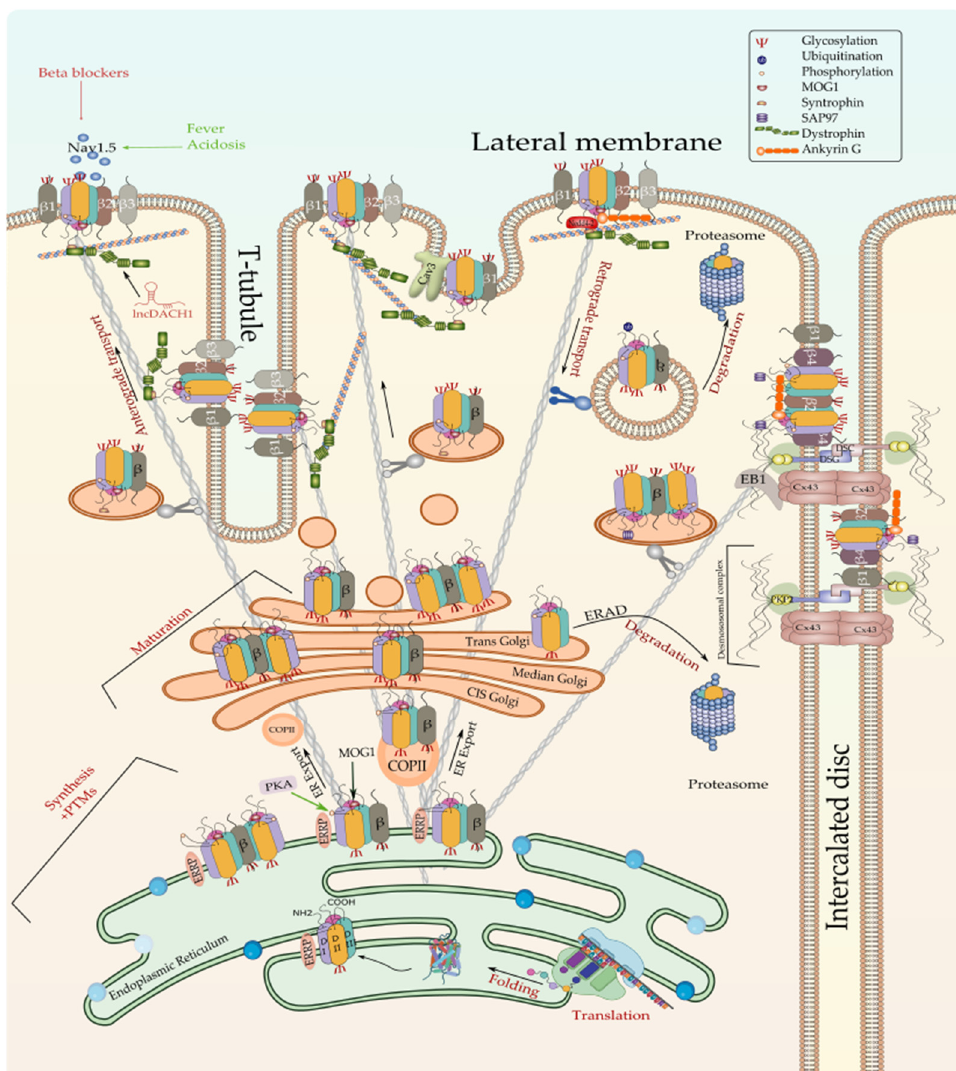
Figure 2. Biosynthesis and degradation pathways of Na v 1.5. Only one of the possible scenarios where Na v 1.5 assembles with one or more β -subunits early at the ER is depicted here. Furthermore, one possible scenario where ERAD-dependent degradation exclusively affects α subunit rather than α - β assembly is shown here since no information is currently available about the detailed process. ERRP—endoplasmic reticulum retention protein; β —beta subunit; PKA—protein kinase A; MOG1— RAN guanine nucleotide release factor; COPII—coat protein complex II; ERAD—ER-associated degradation; Cx43—connexin 43; PKP2—plakophilin 2; DSG—desmoglein; DSC—desmocollin; EB1—end-binding 1; Cav3—caveolin 3; PTMs—post-translational